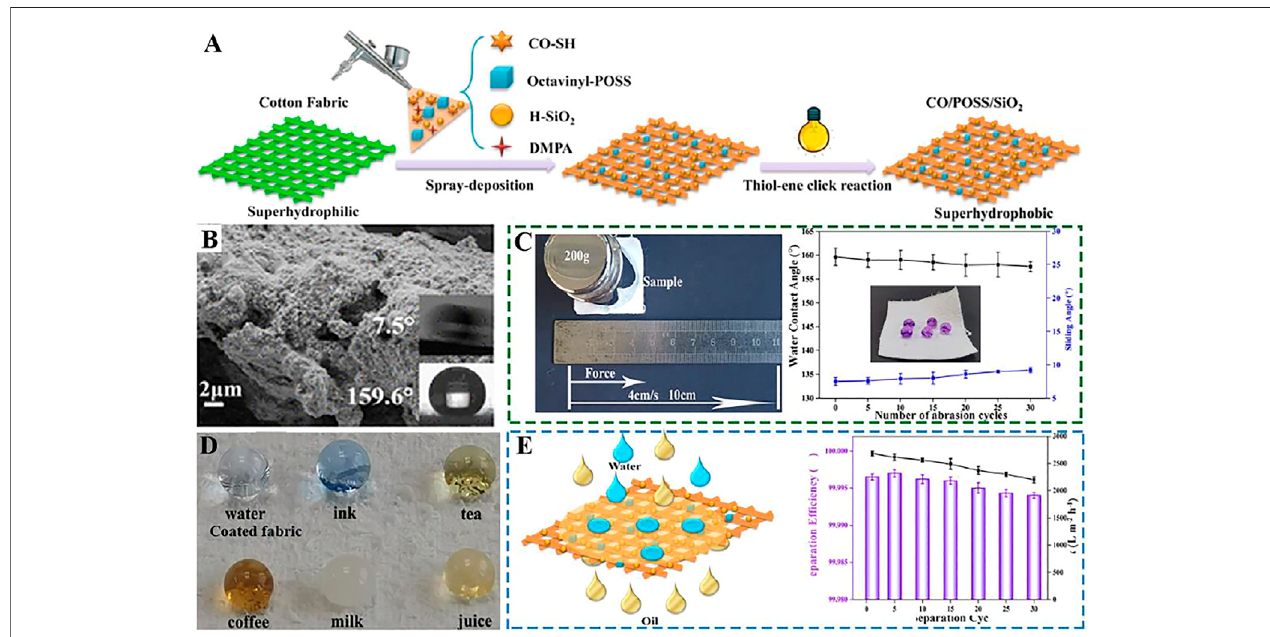
FIGURE 7 | (A) Schematic diagram of superhydrophobic cotton fabrics prepared by spray deposition of the thiol − ene resin and UV curing. (B) SEM images of the superhydrophobicCO/POSS/SiO 2 coatedcottonfabricandtheinsetsarethecorrespondingWCAandSA. (C) SchematicillustrationofthesandpaperabrasionandCA and SA changes after different separation cycles. (D) Photos of different liquids on coated fabrics. (E) Schematic illustration of the separation process of the oil/water mixture and separation ef fi ciency and fl ux of petroleum ether/water mixture after different separation cycles (Shang et al., 2020).